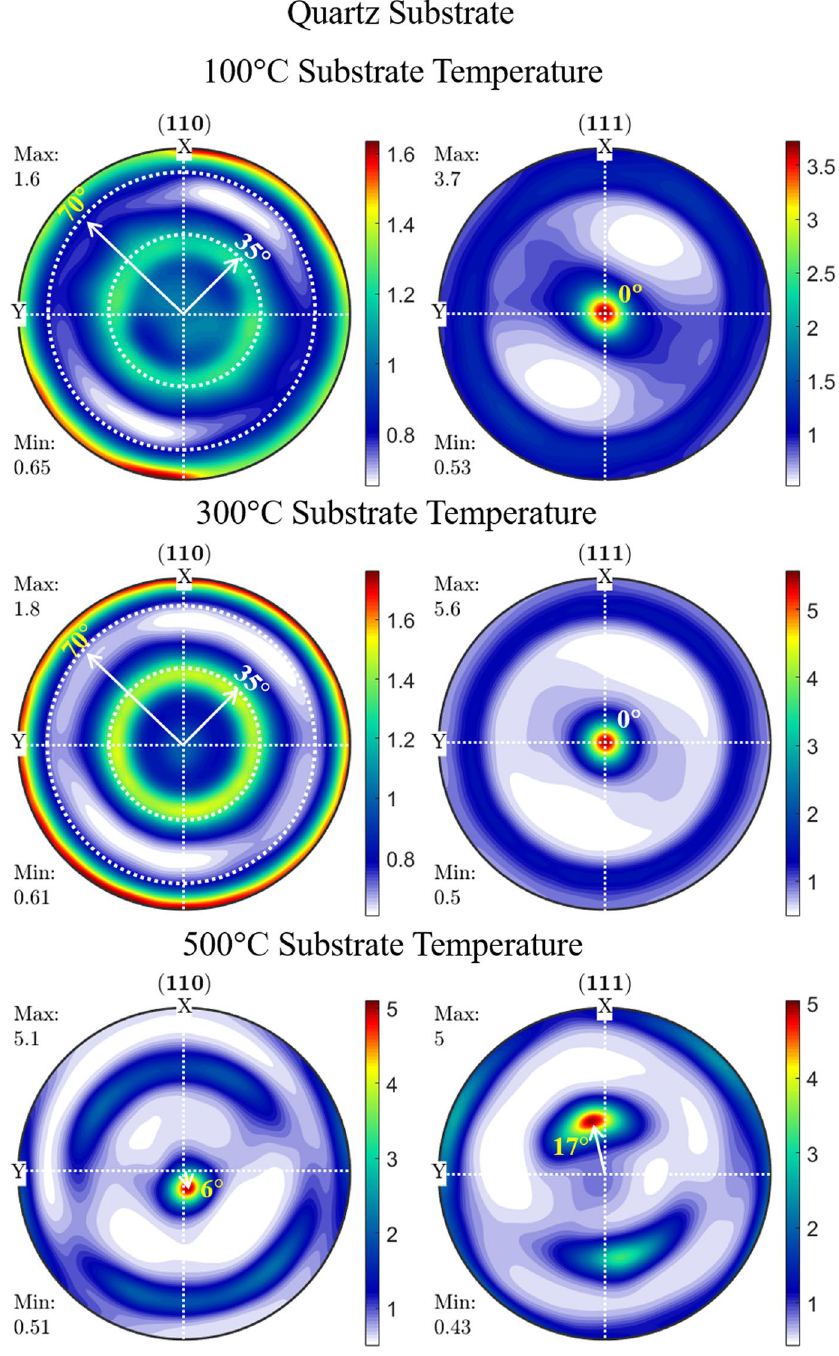
Figure 4. Orientation distribution function extracted from pole figure analysis of SDC film deposited on quartz substrate as a function of substrate